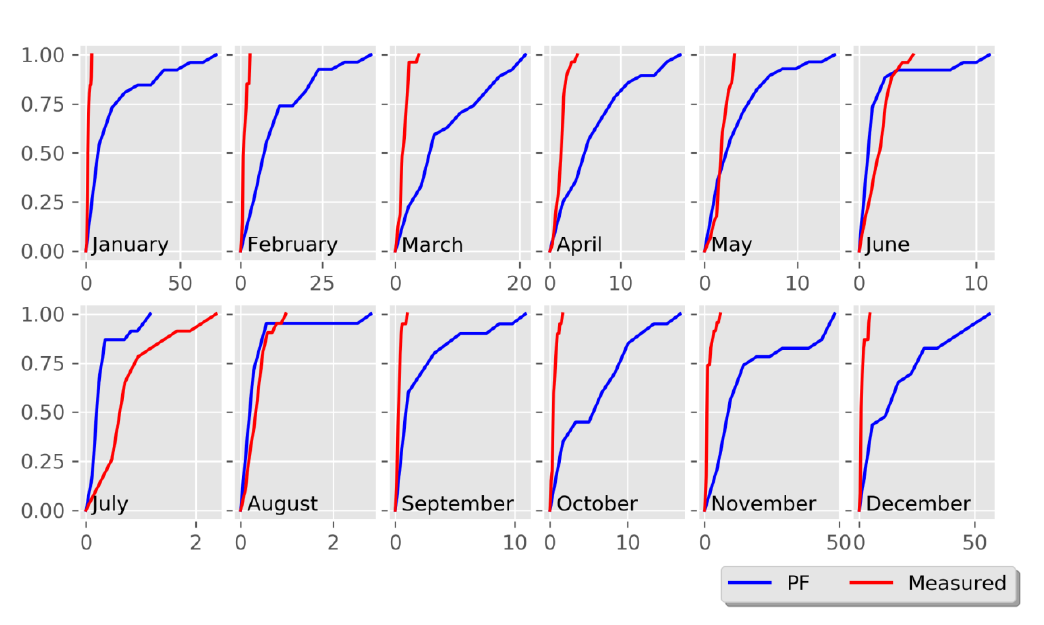
Figure 3. Cumulative distribution functions of the reference simulation (perfect run PF) data and measurements for each month of the year, for the correction period 1981–2010. The x axis represents the average monthly river flow in m 3 /s.